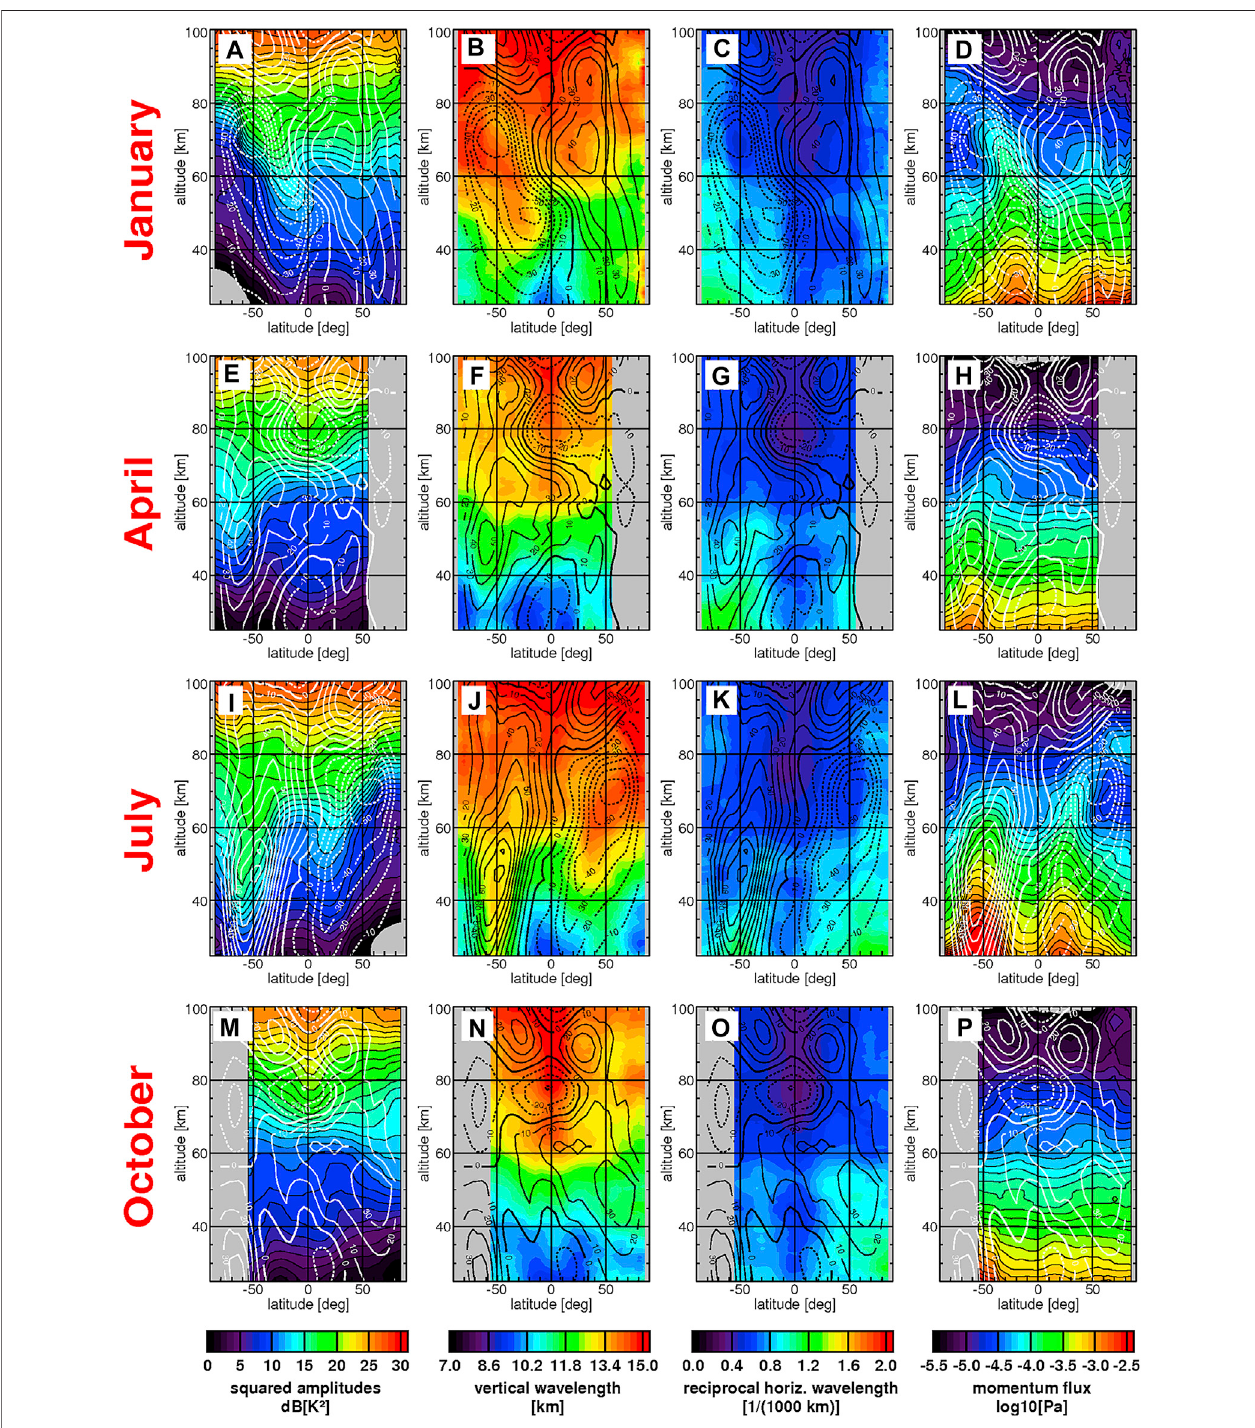
FIGURE 1 | An example of application of the 2D Fourier decomposition. Using this technique, zonal averages of SABER gravity wave (A,E,I, and M) squared temperatureamplitudes, (B,F,J,andN) verticalwavelengths, (C,G,K,andO) reciprocalhorizontalwavelengths,and (D,H,L,andP) momentum fl uxabsolutevaluesfor January(A,B,C,andD),April(E,F,G,andH),July(I,J,K,andL),andOctober(M,N,O,andP)2006hasbeenmeasured.TheoverplottedcontourlinesaretheSPARCzonal windclimatologywhichisarrangedinanincrementof10 m/s;dashedcontourlinesindicatewestwardandsolidlinesareineastwarddirectionwind.Adaptedfrom Figure 5: Ern et al.